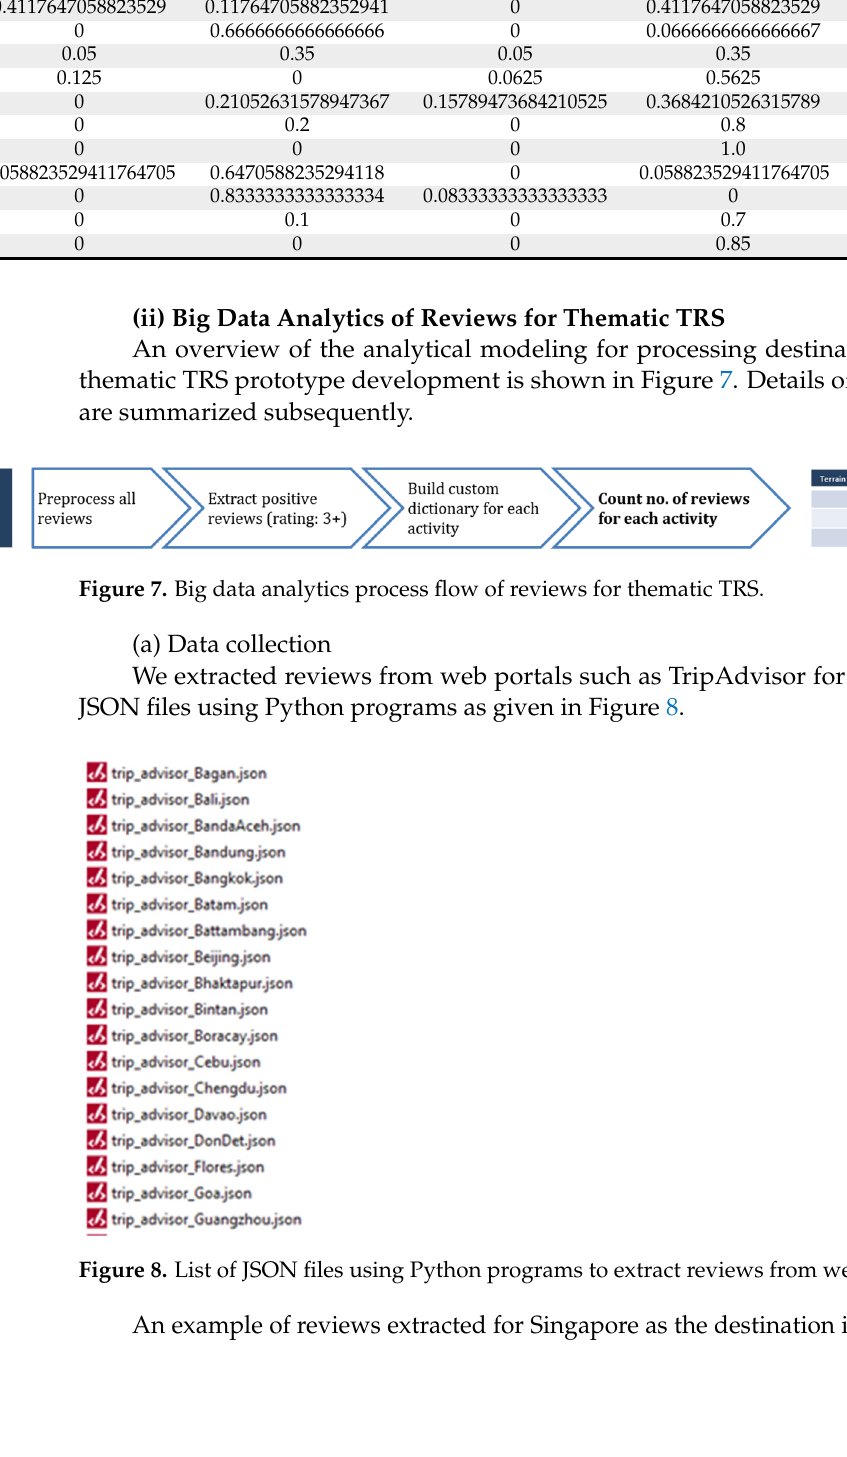
Table 4. Prediction of destination categories using CNN Model.